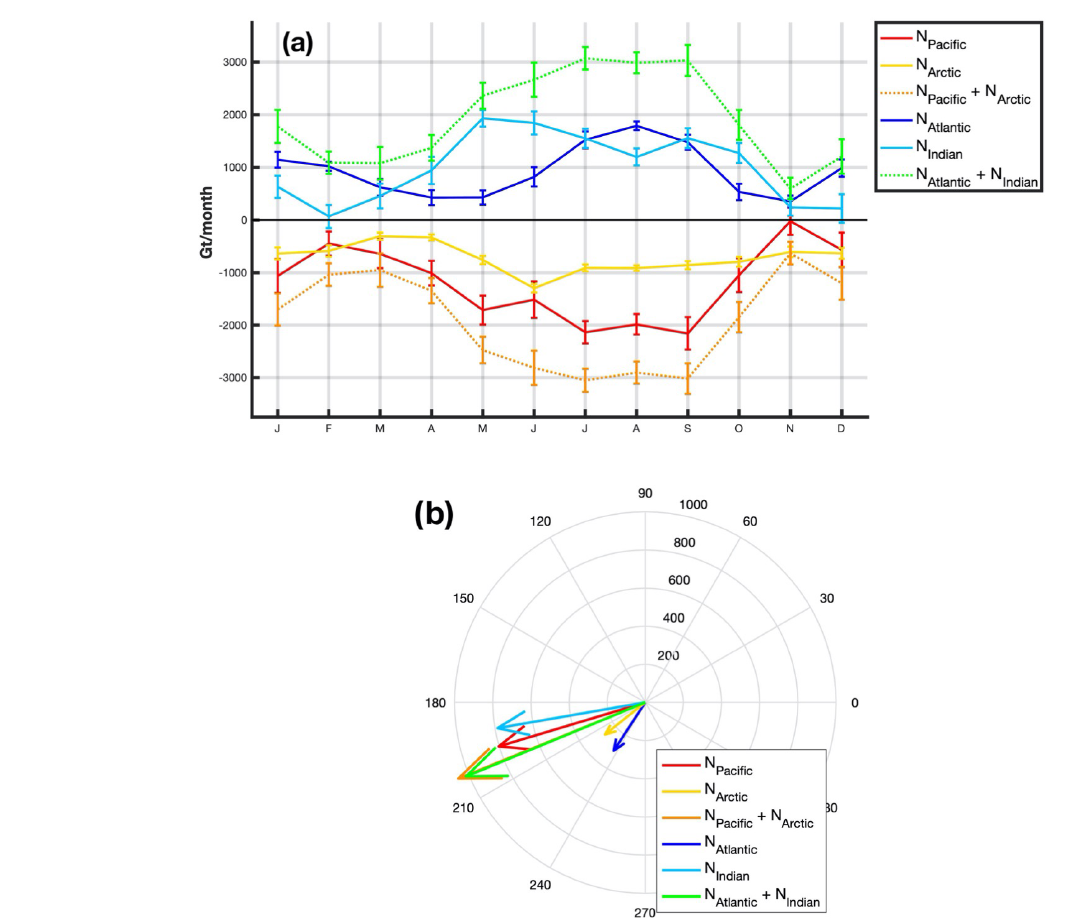
Figure 6. (a) Annual climatology time series (the error bar is 1 standard deviation) and (b) phasor diagram (amplitude in units of Gt per month, phase angle according to Eq. 3) of the inflow and outflow WT of the ocean